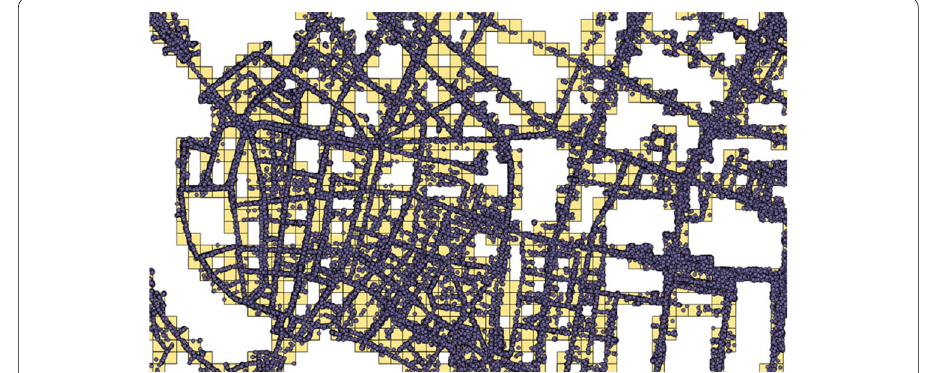
Fig. 1 Road segments mapped to a 100-m